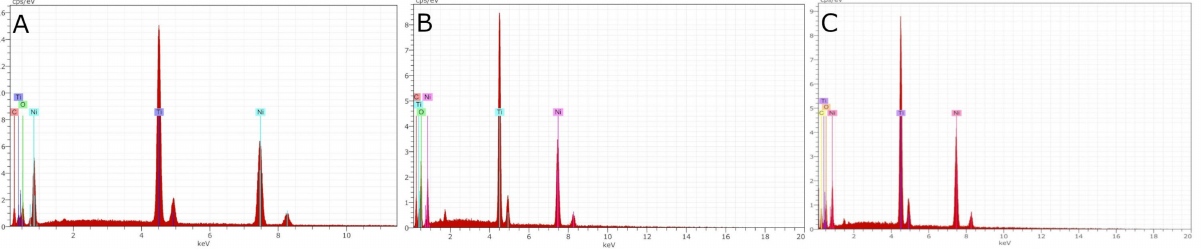
Figure 4. EDX micro-analysis of: ( A ) EDG NiTi alloy endodontic rotary file, ( B ) PMP heat-treated NiTi alloy endodontic rotary file, and ( C ) ST heat-treated NiTi alloy endodontic reciprocating